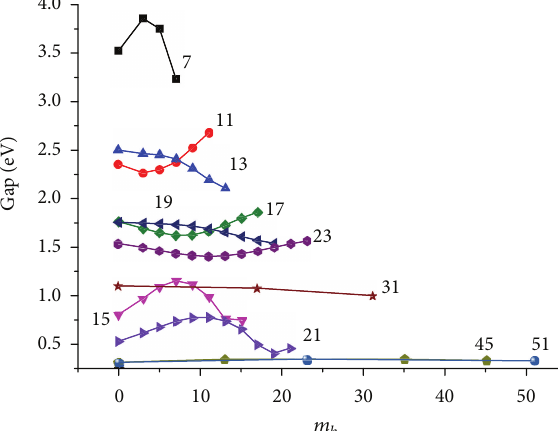
Figure 11: (color online) Dependence of the gap for fixed 𝑚 𝑎 - value onrunning 𝑚 𝑏 (≤ 𝑚 𝑎 ) valuesforselectedhelical [(𝑚 𝑎 , 𝑚 𝑏 ),91] -types of SWSiNTs. The numbers at particular curves are 𝑚 𝑎 -